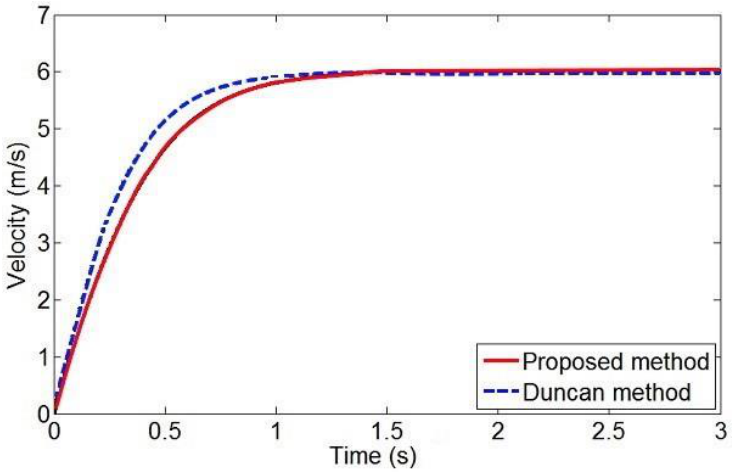
Figure 10. Linear velocity versus time characteristic using the proposed and Duncan’s